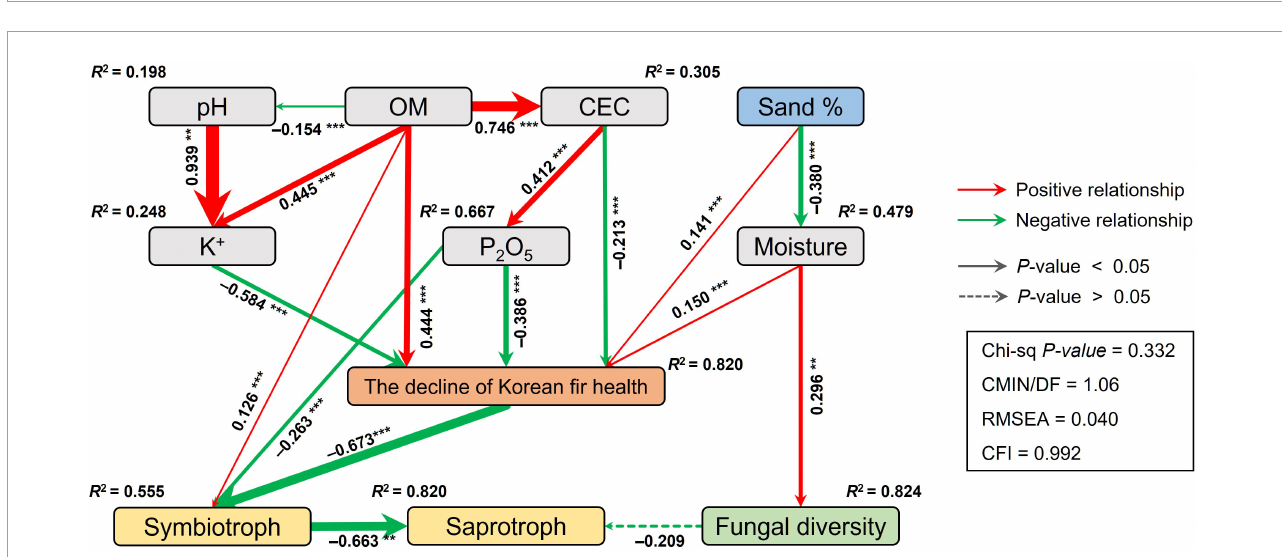
FIGURE5 Structural equation model (SEM) illustrating the direct and indirect effects of the soil physico-chemical properties on the decline of Korean fir health and the fungal community. Continuous and dashed arrows represent the significant and non-significant relationships, respectively. The adjacent numbers that are labeled in the same direction as the arrow represent path coefficients, and the width of the arrow is in proportion to the degree of path coefficients. Red and green arrows indicate positive and negative relationships, respectively. R 2 values denote the proportion of variance explained by each variable. OM, organic matter; CEC, cation exchange capacity. Significance levels: * p < 0.05, ** p < 0.01, *** p <